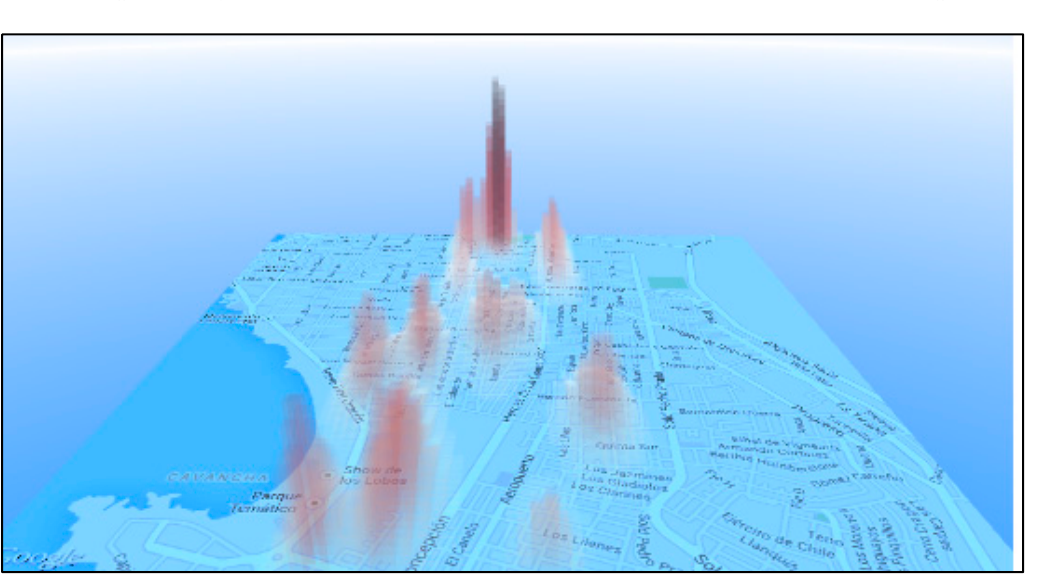
Figure 8. People in unsafe